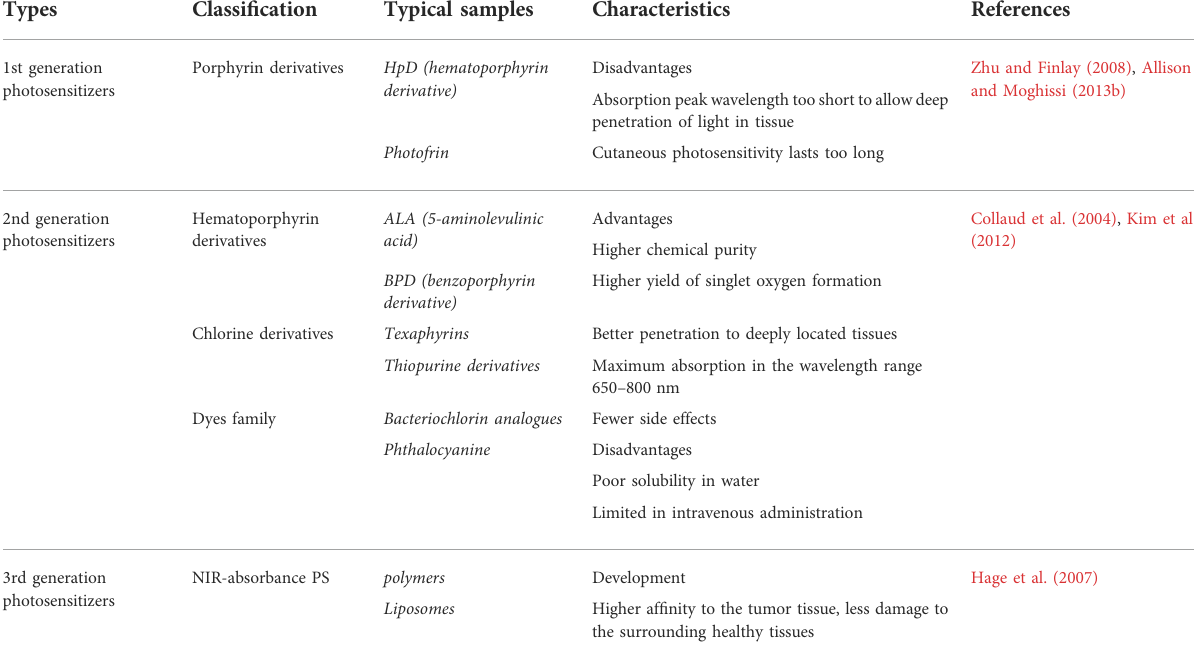
TABLE 1 A summary of kinds of photosensitizers and their